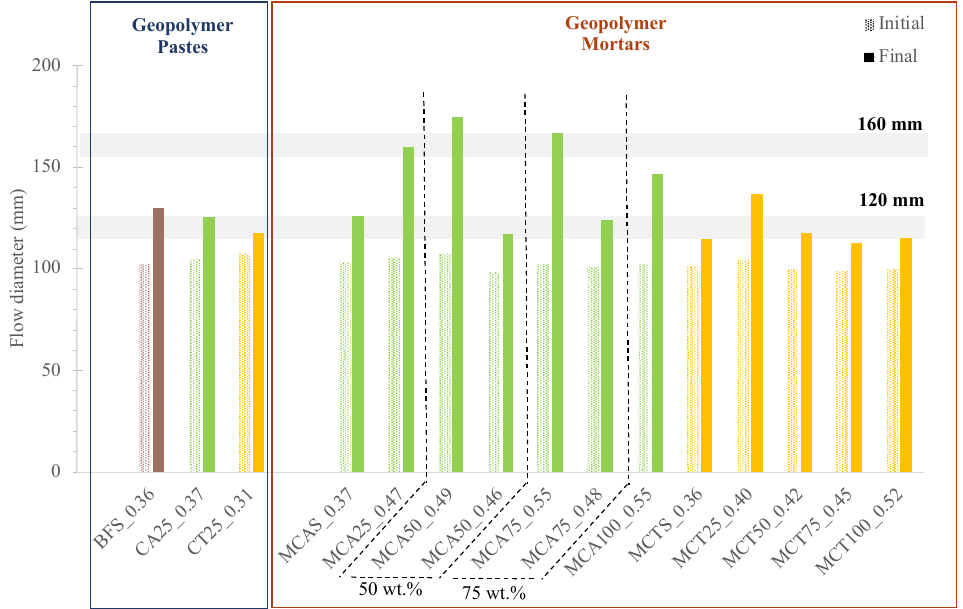
Figure 5. Flow table results of all prepared geopolymer formulations.